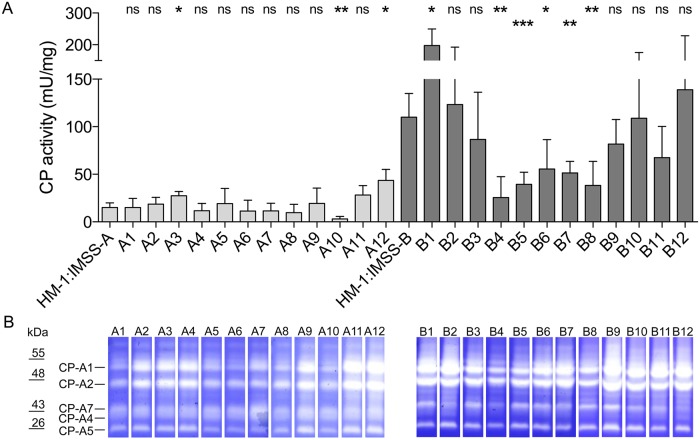
Determination of cysteine peptidase activity.(A) CP activities of cell line HM-1:IMSS-A, clones A1–A12, cell line HM-1:IMSS-B and clones B1–B12 were measured at least four times in duplicate. (B) Substrate gel electrophoresis of clones A1–A12 and clones B1–B12. Cell lysates were separated on SDS-PAGE co-polymerised with gelatine. To visualise CP activity of proteins, gels were stained with Coomassie blue and the images were inverted. Standards are indicated on the left (kDa). Significance (p-values) was established using an unpaired t test. p-values were calculated relative to control (HM-1:IMSS-A or HM-1:IMSS-B, respectively). *p < 0.05, **p < 0.005, ***p < 0.001, ns: not significant. For detailed information see S1 Table.